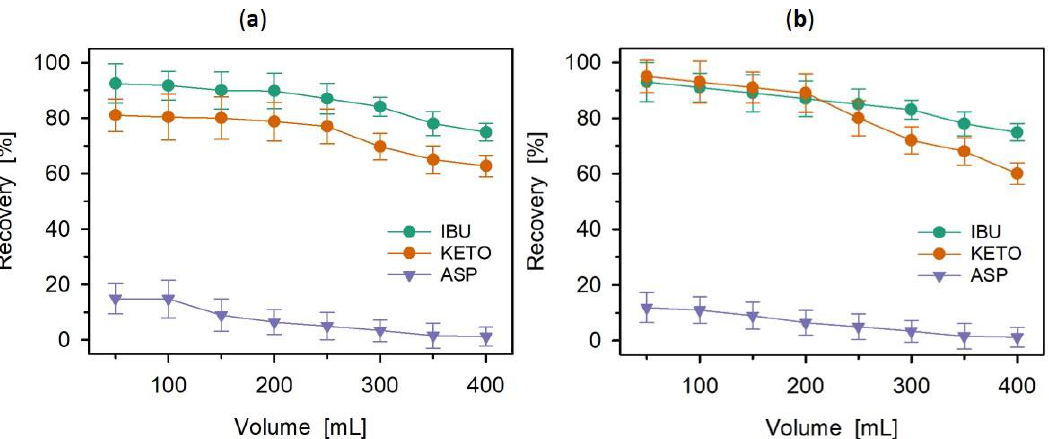
Figure 9. Effect of the sample volume on the recoveries obtained for ibuprofen (IBU), ketoprofen (KETO) and aspirin (ASP) on the ( a ) poly(4VP- co -14DMB) and ( b ) poly(4VP- co -TRIM) copolymers; (mean (bar) ± standard deviation (whisker) ( n = 3)).